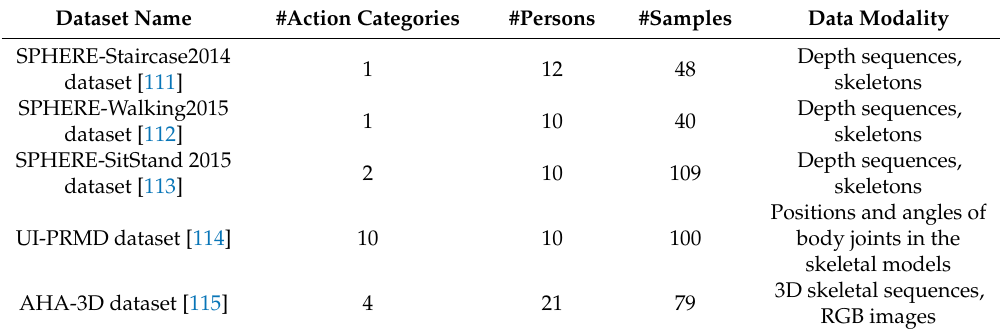
Table 2. Physical rehabilitation